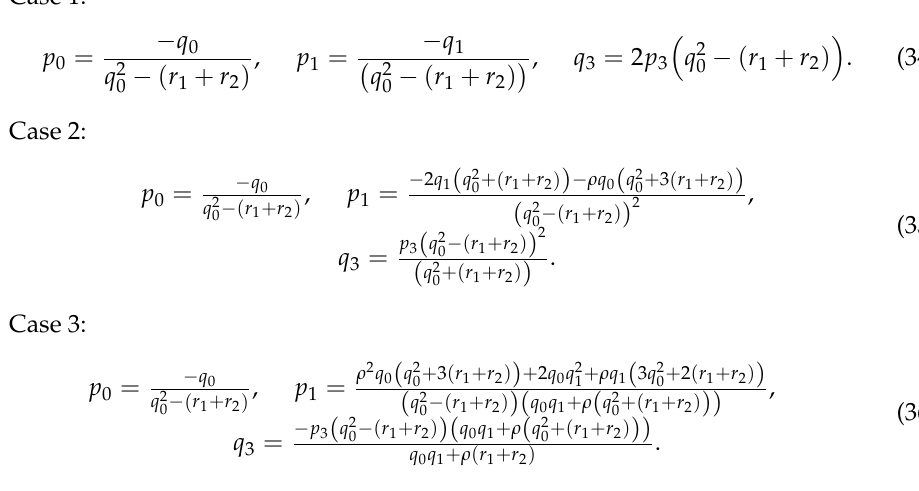
and with the parameters and for the fractional order 𝐹𝐹 2 ( 𝑥𝑥 , 𝑑𝑑 ) 𝐺𝐺 2 ( 𝑥𝑥 , 𝑑𝑑 ) 𝜌𝜌 = 𝜏𝜏 = 1 𝛼𝛼 = 0.85 𝐼𝐼𝐼𝐼 [ 𝐺𝐺 2 ( 𝑥𝑥 , 𝑑𝑑 )].